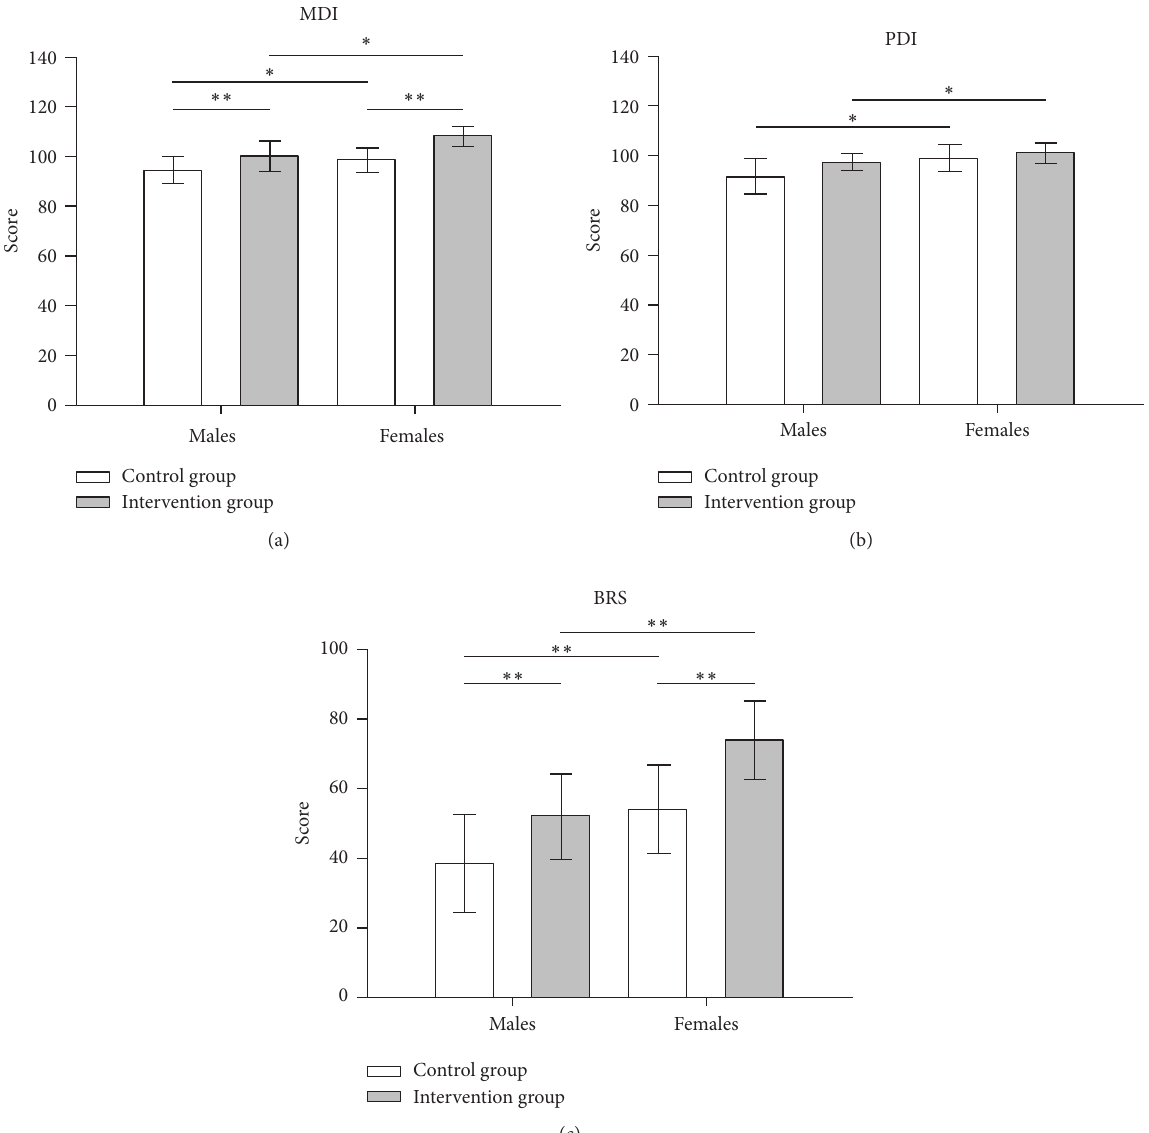
Figure 1: Graphical representation of the multiple regression analysis results for each BSDI II index: (a) mental development index, MDI; (b) psychomotor development index, PDI; and (c) behavioural rating score, BRS. ∗ corresponds to 𝑝 < 0.05 and ∗∗ to 𝑝 < 0.01 . Note that indexes changes induced by treatment substantially have the same magnitude in both genders. Consequently, treatment is effective in both genders to the same extent (additive